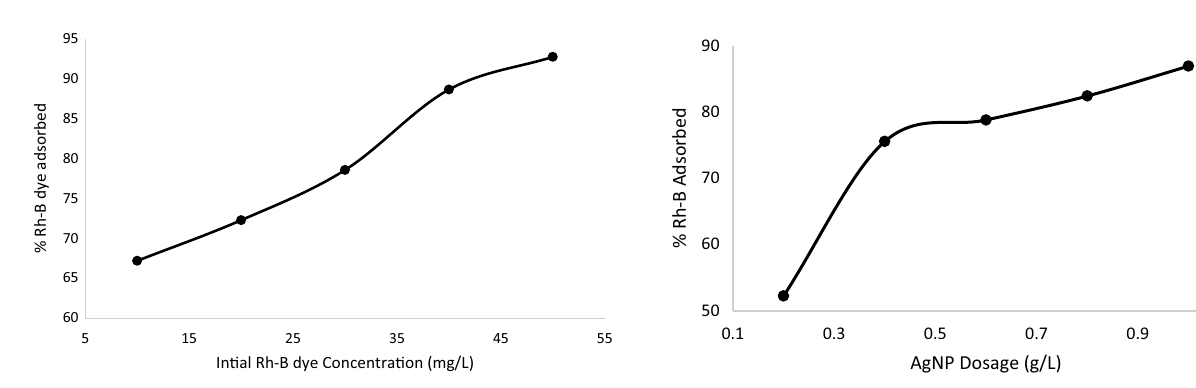
Fig. 7 Effect AgNPs dosage on the adsorption of Rh-B. 50 mg/l Rh-B, agitation speed—150 rpm, agitation time—30 min at 303 K, pH